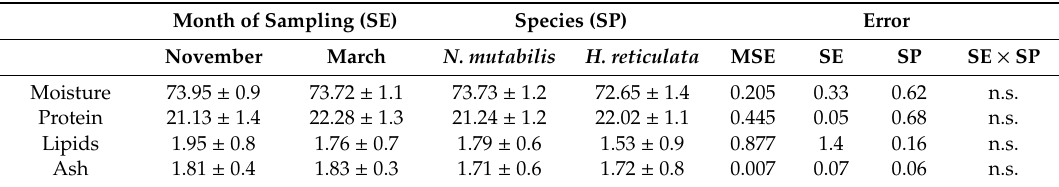
Table 2. Proximate composition (% as it is) of the two species of sea snails according to season of sampling (SE) and species